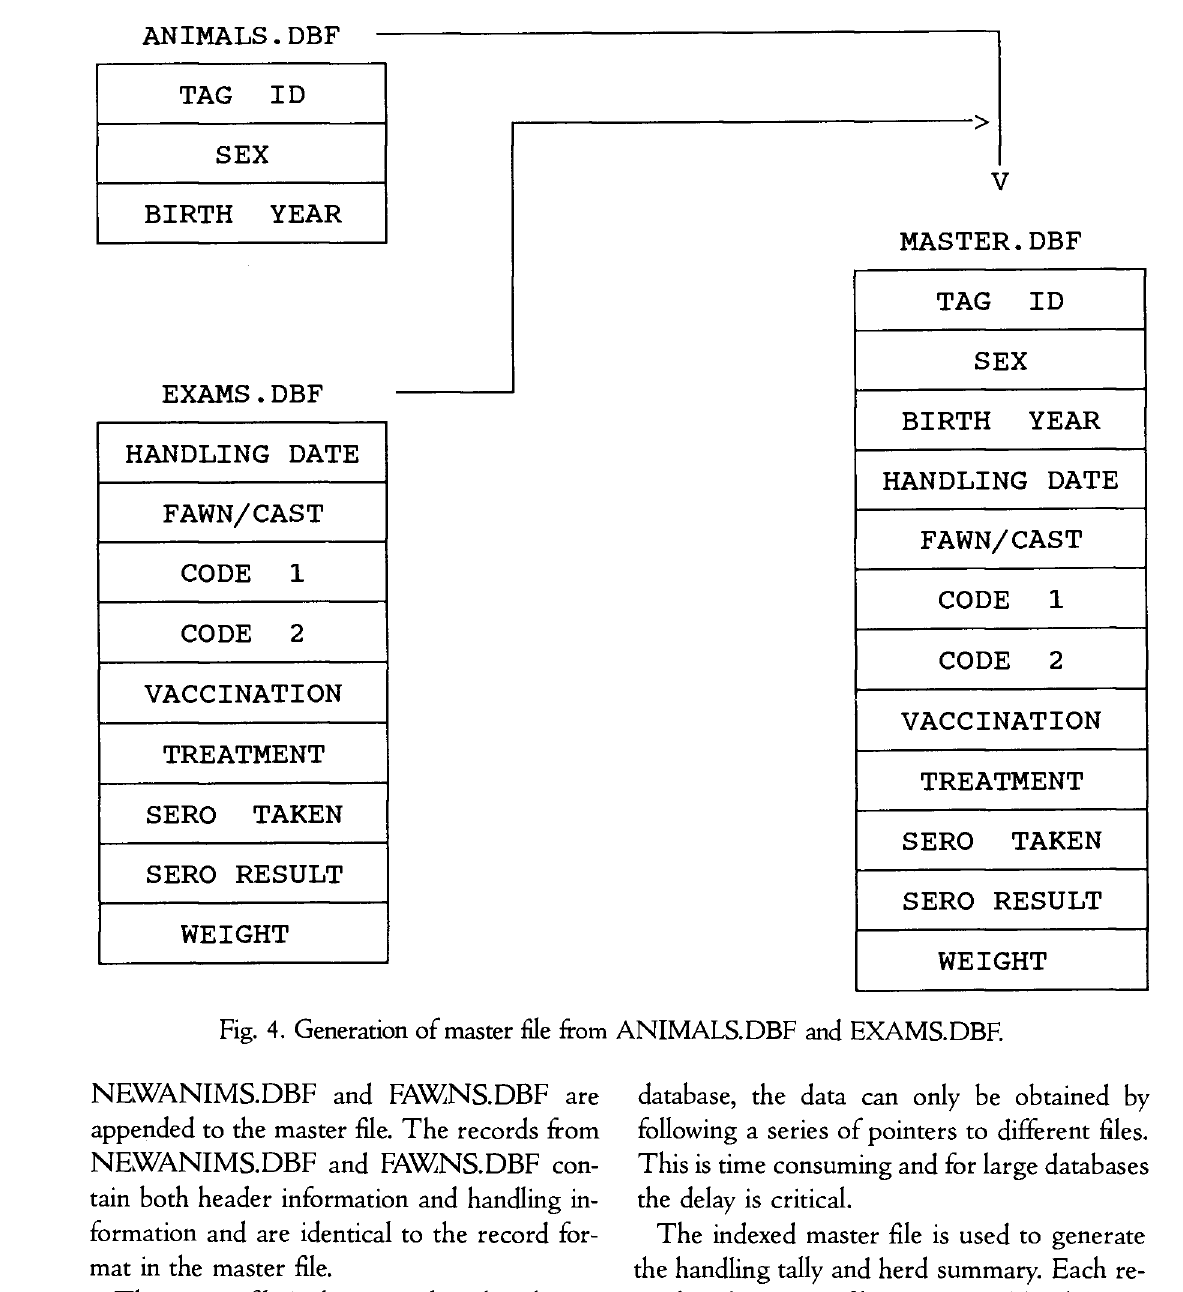
Fig. 4. Generation of master file from A N I M A L S . D BF and EXAMS.DBF. N E W A N I M S. D